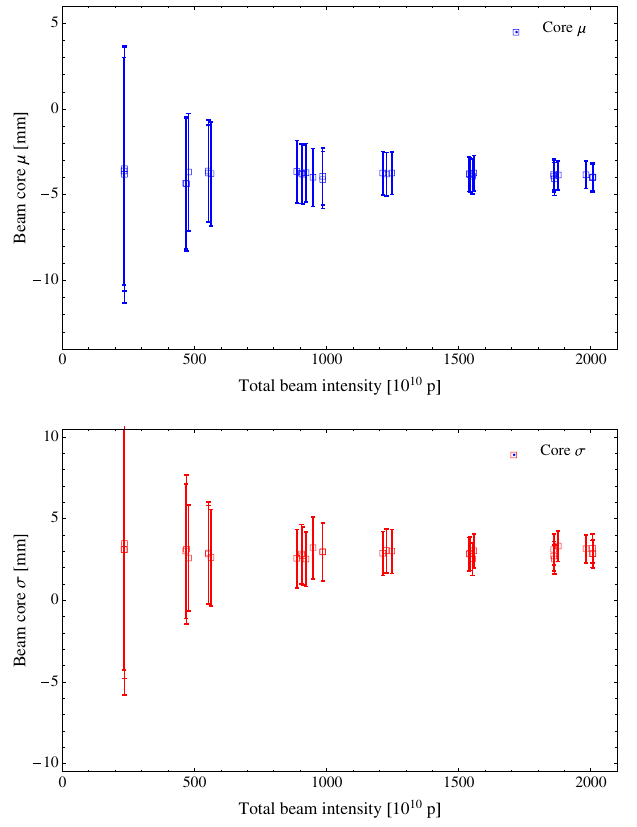
FIG. 8. Beam core position (cid:5) c (upper) and sigma (cid:6) c (lower), from the fit using Eq. (6) of the data shown in Fig. 7, vs total beam intensity. The error bars represent the error associated with the fitting procedure. The larger errors for lower total beam intensities reflect the difficulty of representing the close-by peaks with five Gaussian distribution functions, and also the effect of the constant gain used for the wire scanner throughout the whole measurement campaign. Neither (cid:5) c nor (cid:6) c feature any dependence on the total beam intensity.